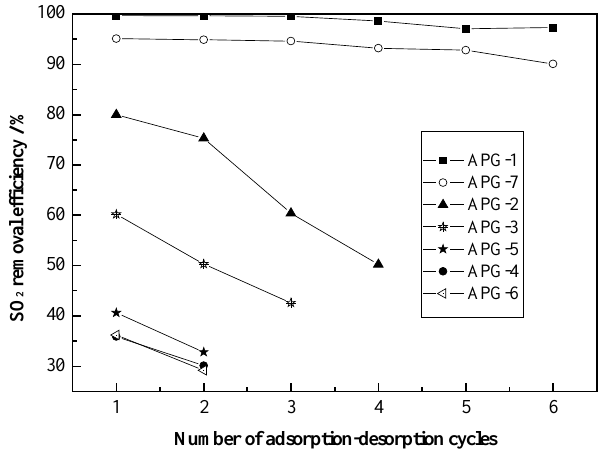
Figure 8. SO 2 adsorption-desorption cycles on different samples.